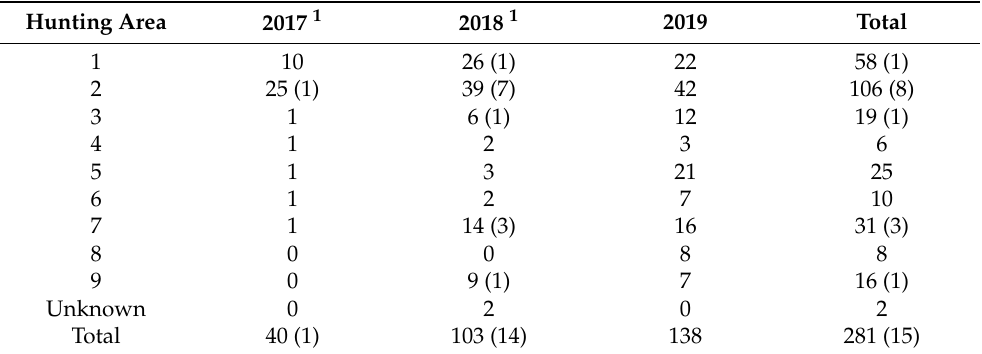
Table 1. A total of 281 Icelandic wild Eurasian tundra reindeer ( Rangifer tarandus tarandus ) (2017–2019) with all the nine hunting areas represented were investigated for antibodies against a panel of potential viral pathogens.